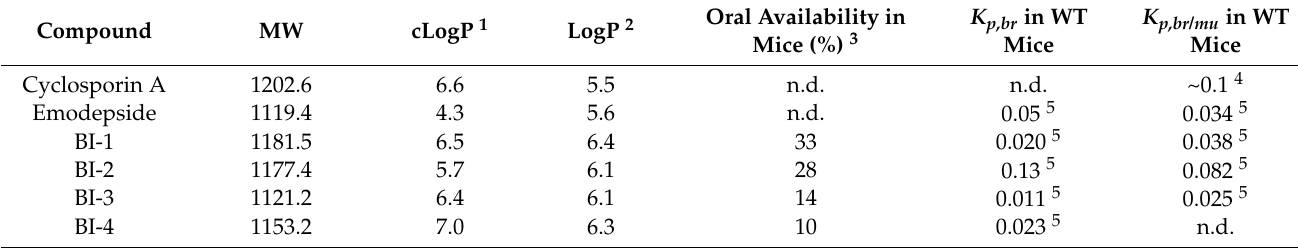
Table 1. Cyclopeptides used in this study.